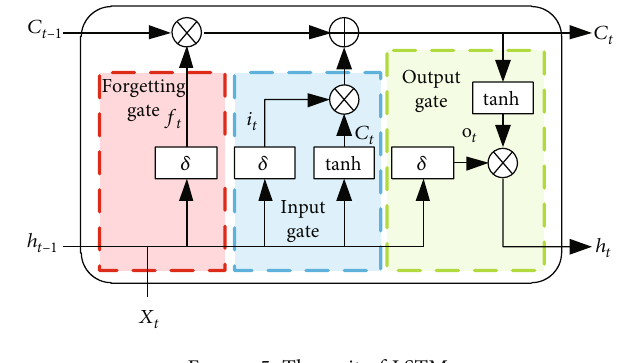
in turning maneuver mode. (a) is the variation of r a